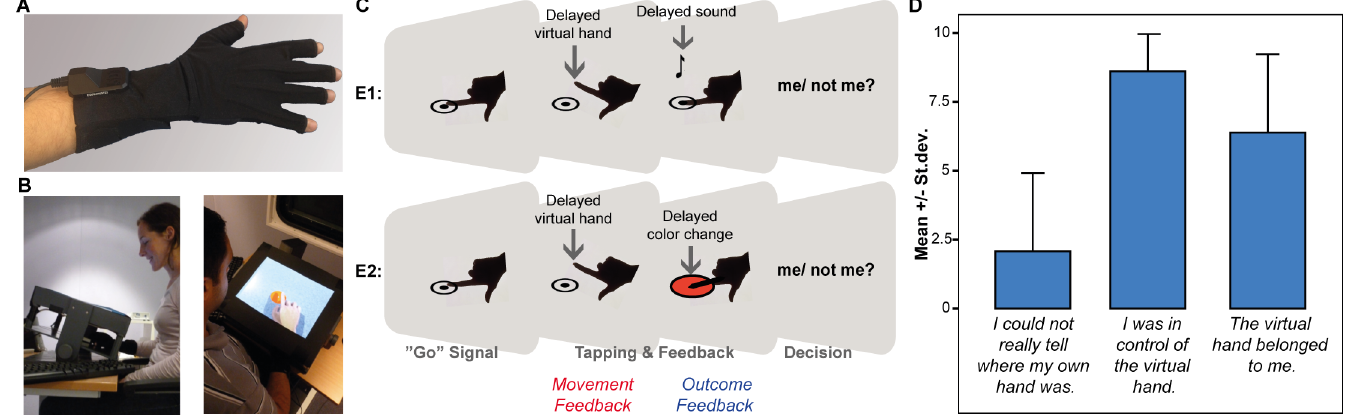
Fig 1. Experimental Setup and Tasks. (A) Participants wore a sensor glove to track their movements. (B) They were seated in front of an inclined computer screen and placed their gloved hand on a board underneath the screen. While performing voluntary finger movements (finger taps), participants receive real-time visual feedback from a simulated virtual hand, displayed on the screen in spatial alignment with their hidden real hand. (C) The figure schematically displays the course of a trial. Participants performed two consecutive experiments. Experiment 1 (E1): After an auditory cue, participants performed a single tap with their index finger (as if pressing a button), which evoked a click sound. Sometimes the onset of the virtual hand ’ s movement was delayed (feedback about movement or ‘ hand ’ condition). Sometimes the sound was delayed ( ‘ outcome audio ’ condition). Each trial had to be evaluated as self- or other-generated. Experiment 2 (E2): In a visual control version, participants ’ taps evoked a color change in a virtual button ( ‘ outcome color ’ condition). (D) Thirteen pilot participants evaluated the set-up after a cycle of continuous tapping without delay by rating their agreement on a scale from 1 to 10 (10 = “ I absolutely agree ” ) with respect to three questions related to ownership and agency over the virtual